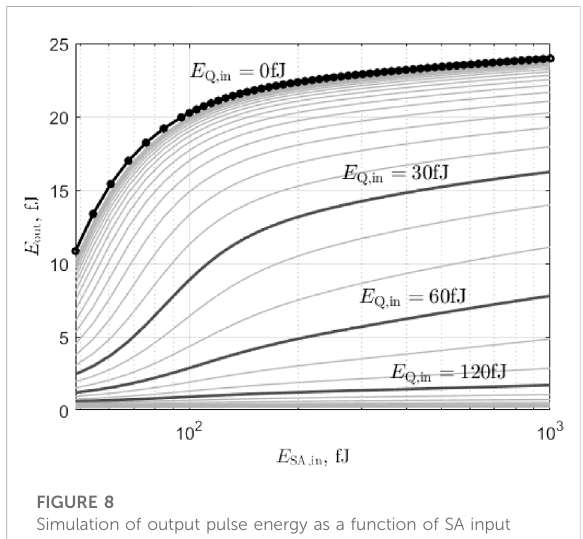
FIGURE 8 Simulation of output pulse energy as a function of SA input pulse energy for different GQ input pulse energy and for i bias = 13